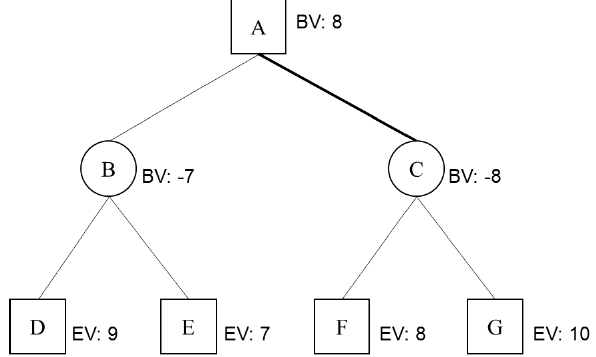
Figure 2. Minimax search process: EV represents the evaluation value ( e _ val ) of a leaf node, and BV represents the backup value ( b _ val ) of each upper-level node.